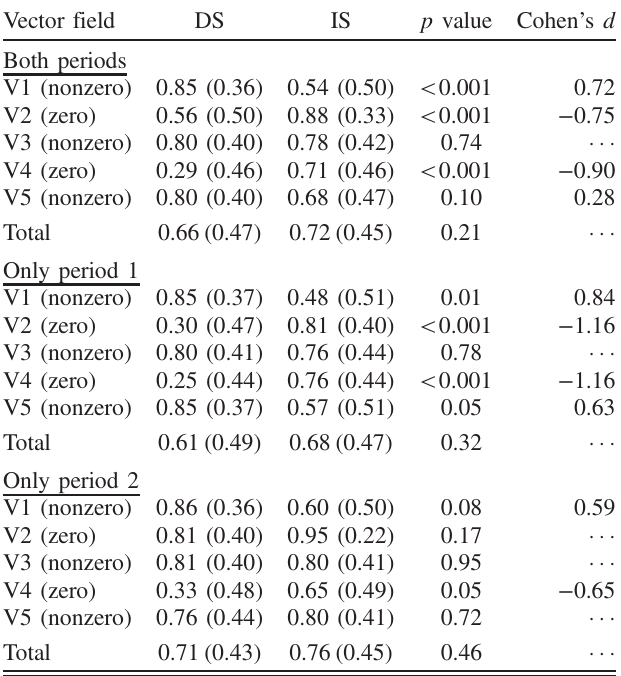
TABLE II. Average scores and standard deviation for all vector field plots V1 – V5 (zero or non-zero divergence is indicated in parentheses) and both strategies collected from both instruction periods (DS ¼ differential strategy; IS ¼ integral strategy). Statistics refer to a two-tailed paired t -test ( N ¼ 41 ).